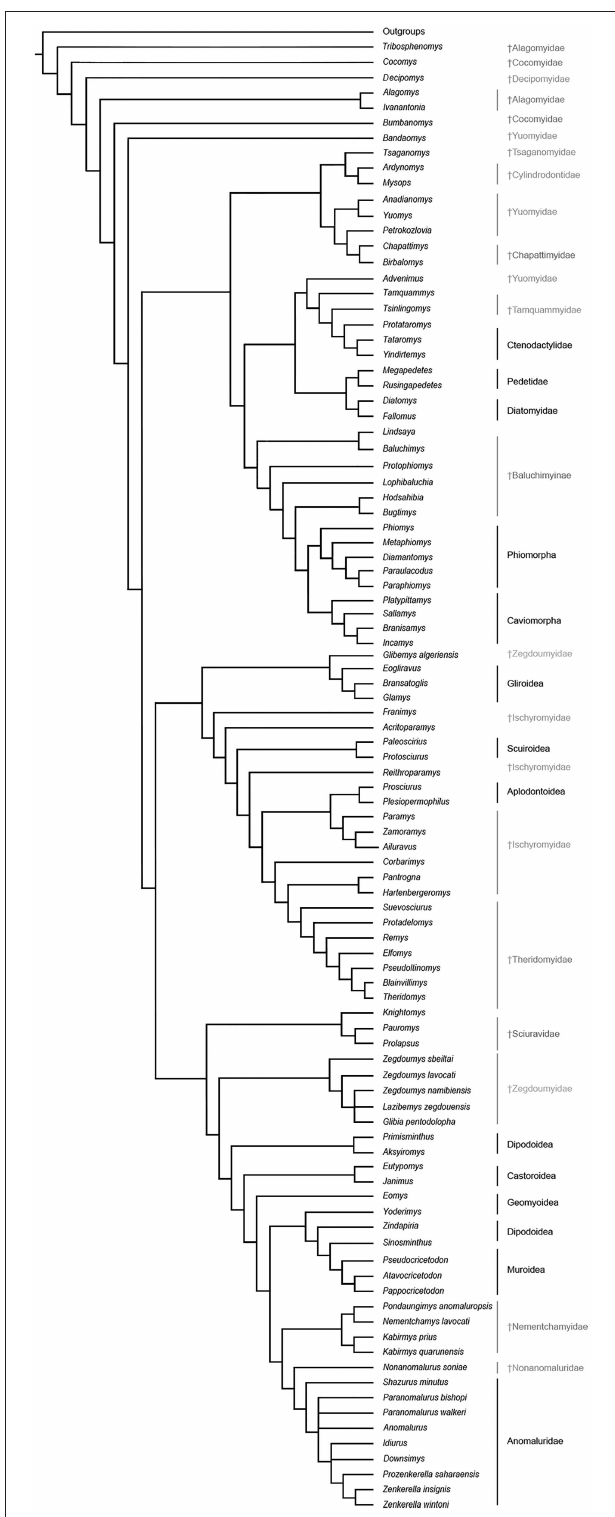
FIGURE 8 | Phylogenetic relationships among living and fossil anomaluroids and other rodents based on morphological (primarily dental) data. Strict consensus of 40 equally parsimonious trees based on